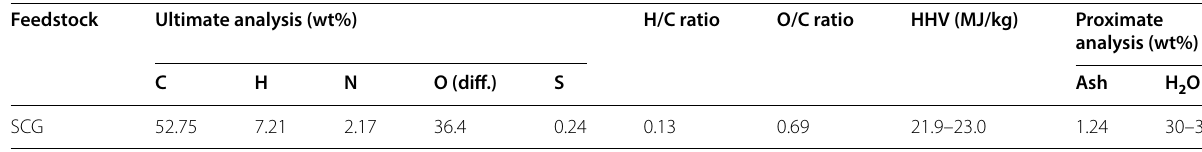
Table 1 Ultimate analysis of some properties on dry basis and some of physical properties of the tested SCG feedstock